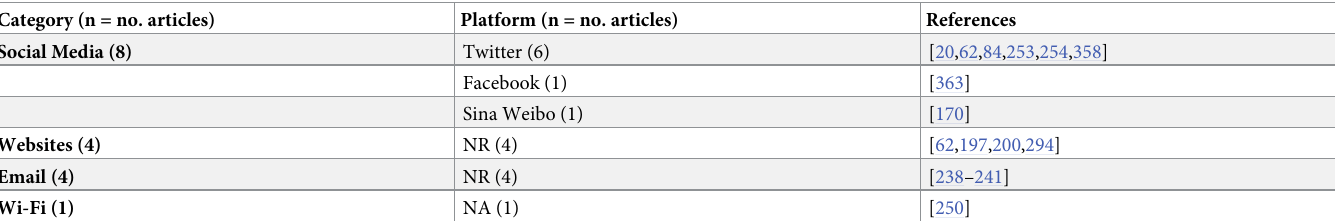
Table 15. Number of articles predicting education level, with associated platforms and references. Category (n = no.